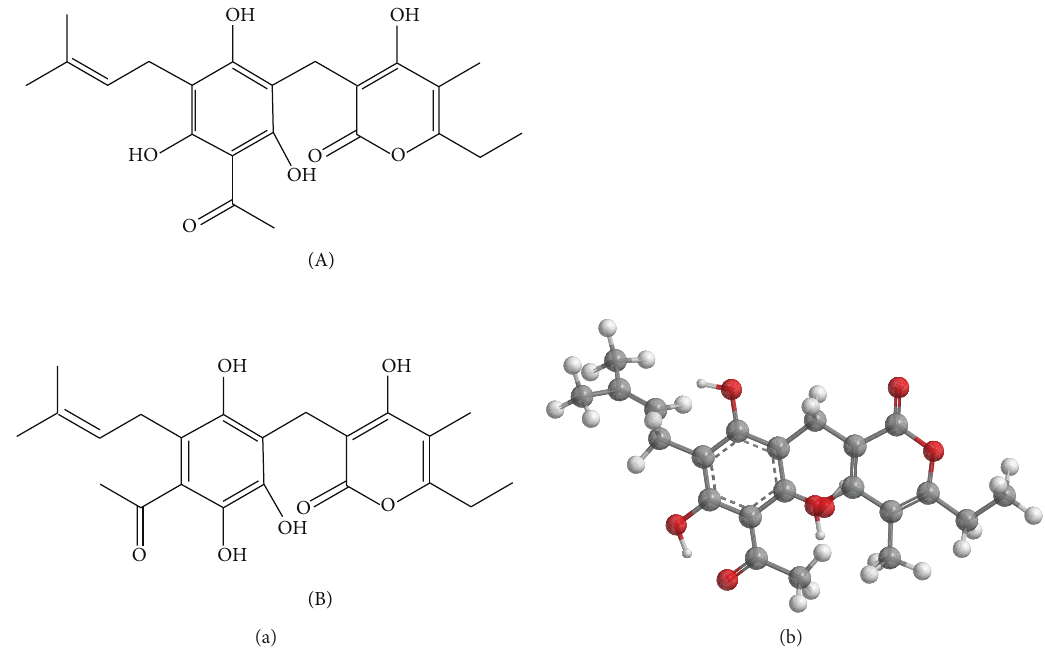
Figure 2: (a) Chemical structure of arzanol (A) and homoaranol (B), (b) 3D structure of arzanol: 3-(3-acetyl-2,4,6-trihydroxy-5-(3-